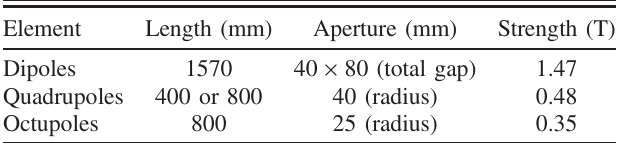
TABLE I. Parameters of the HEBT elements. Element